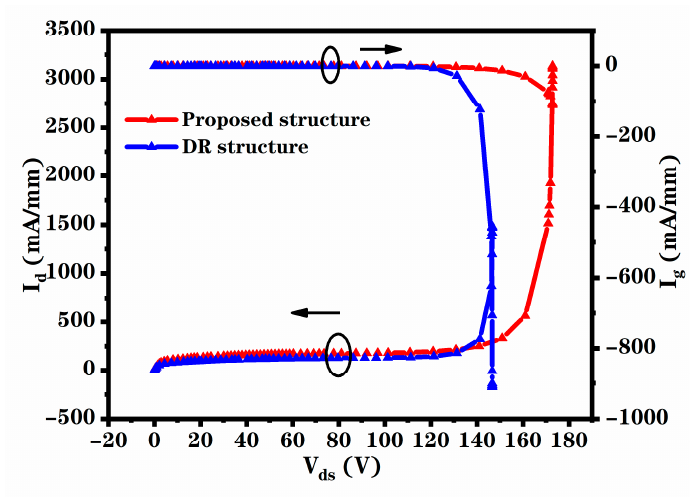
Figure 4. Breakdown performance of the proposed structure and DR structure.